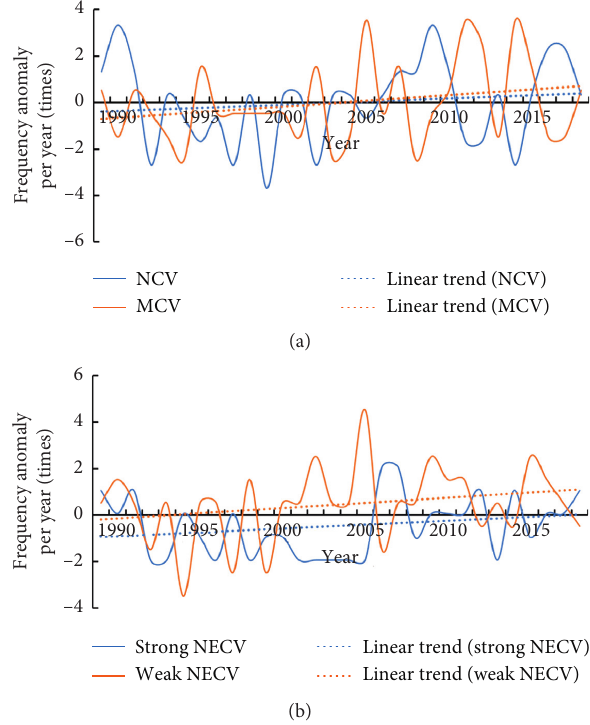
Figure 3: Interannual variation in the occurrence of NECVs with different types (unit: times).